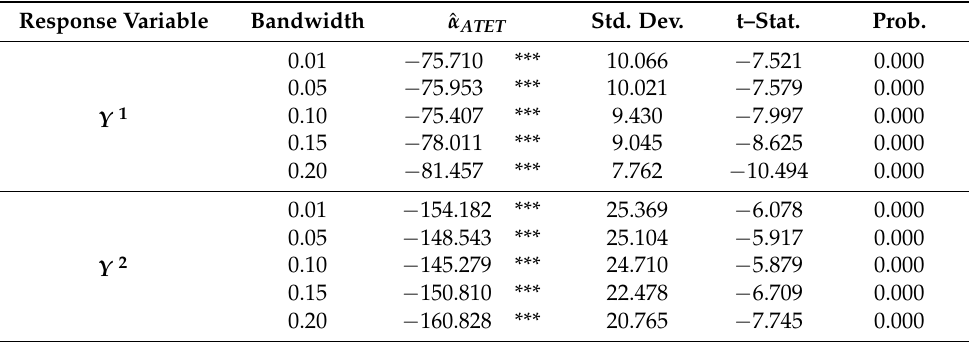
Table 5. ATET estimation—Kernel